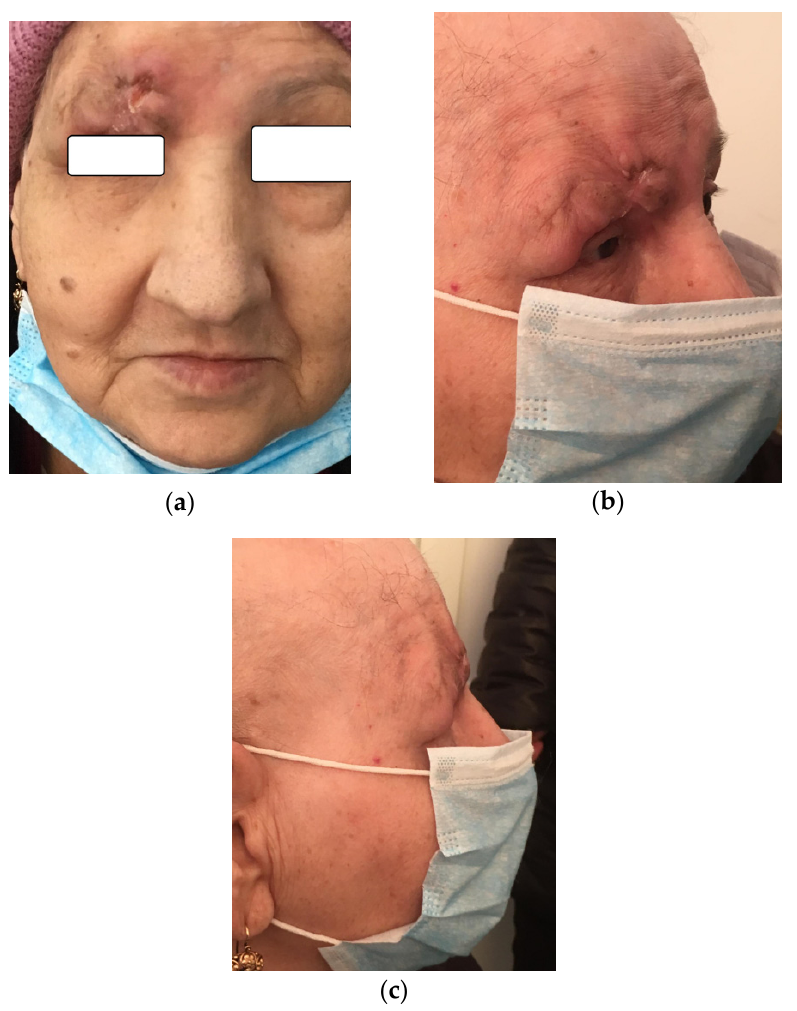
Figure 8. ( a – c ) Clinical remission following chemotherapy.